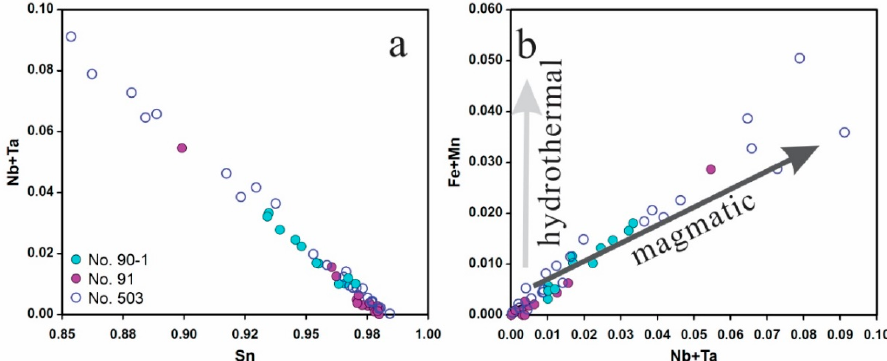
Figure 8. Binary plots for cassiterite based on EPMA data (in a.p.f.u.). ( a ) Nb + Ta vs. Sn binary plot and ( b ) Fe + Mn vs. Nb + Ta binary plot. The hydrothermal and magmatic evolutionary paths of cassiterite compositions are cited from Breiter et al.